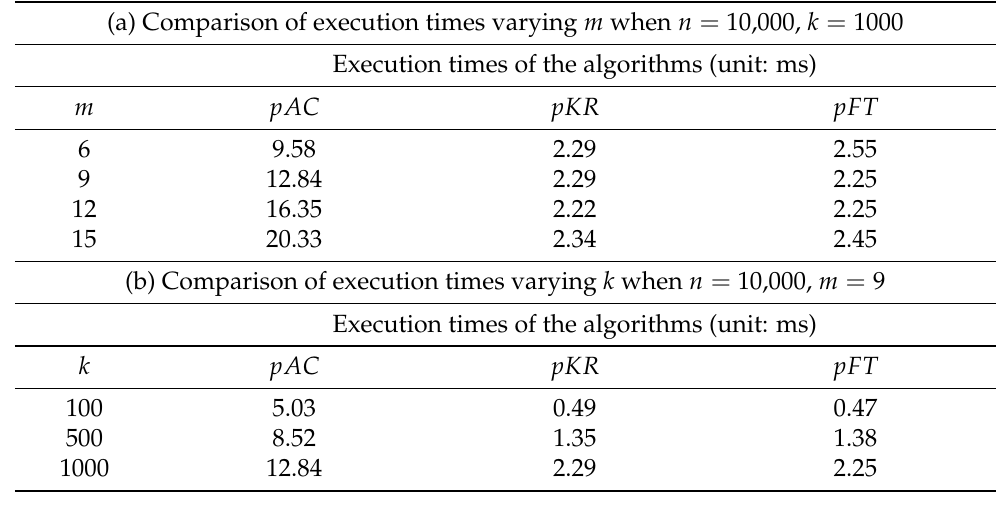
Table 3. Comparison of execution times of pAC , pKR , and pFT for Dow Jones Index